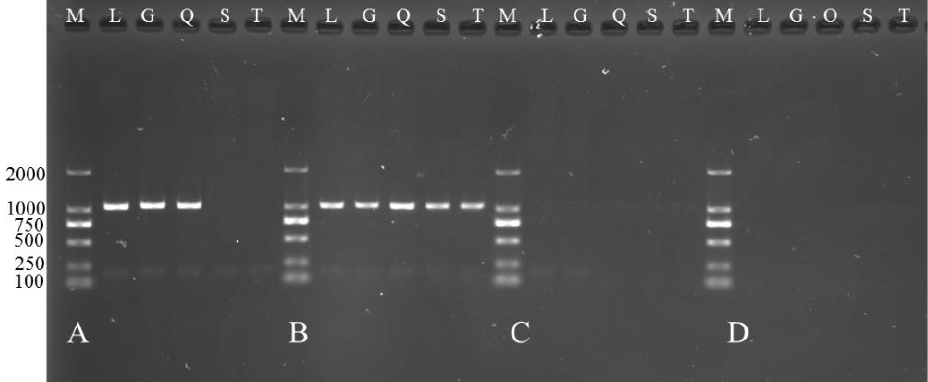
Figure 8. Expression of TCONS_00102859 in skeletal muscle at different ages in Ujumqin and Texel. (A) Expression of TCONS_00102859 in skeletal muscle of 85-day-old Texel fetus. (B) Expression of TCONS_00102859 in skeletal muscle of Texel neonate. (C) Expression of TCONS_00102859 in skeletal muscle of 85-day-old Ujumqin fetus. (D) Expression of TCONS_00102859 in skeletal muscle of Ujumqin neonate. From left to right, the samples are markers (M), longissimus dorsi (L), gastrocnemius muscle (G), quadriceps femoris (Q), scapula muscle (S) and triceps (T).